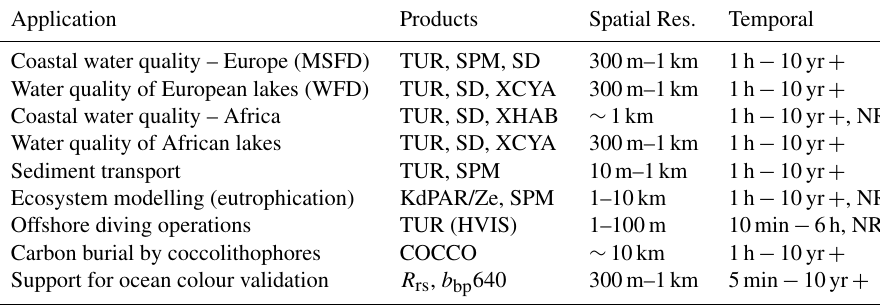
Table 3. Summary of SEVIRI ocean colour applications requested by users.